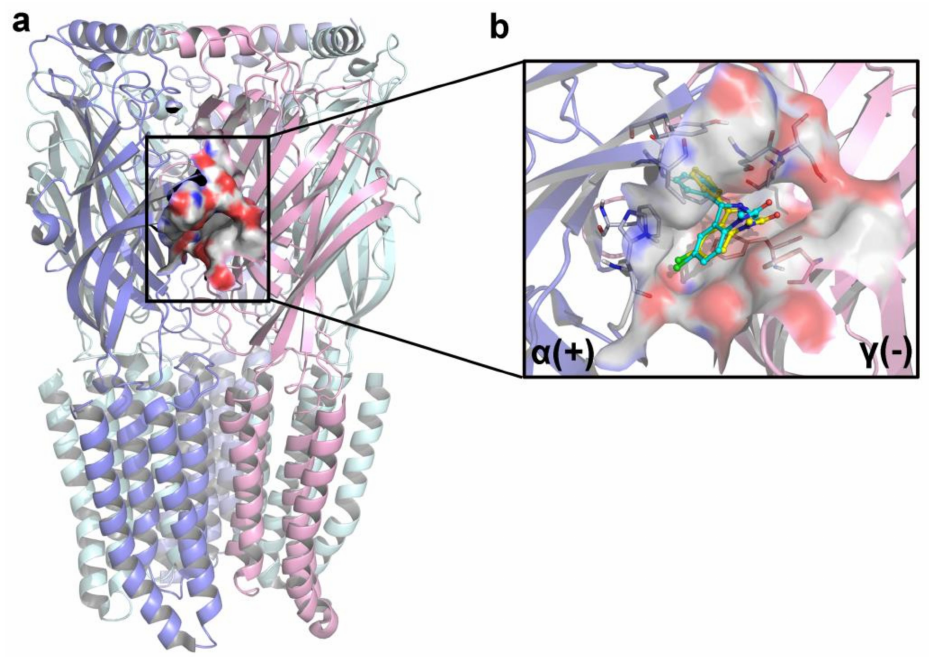
Figure 7. ( a ). The BZD binding pocket of human α 1 β 2 γ 2 GABA A R (PDB ID: 6X3X); ( b ) binding conformations of the original ligand DZP (cyan) and the re-docked DZP (yellow) at the binding site.